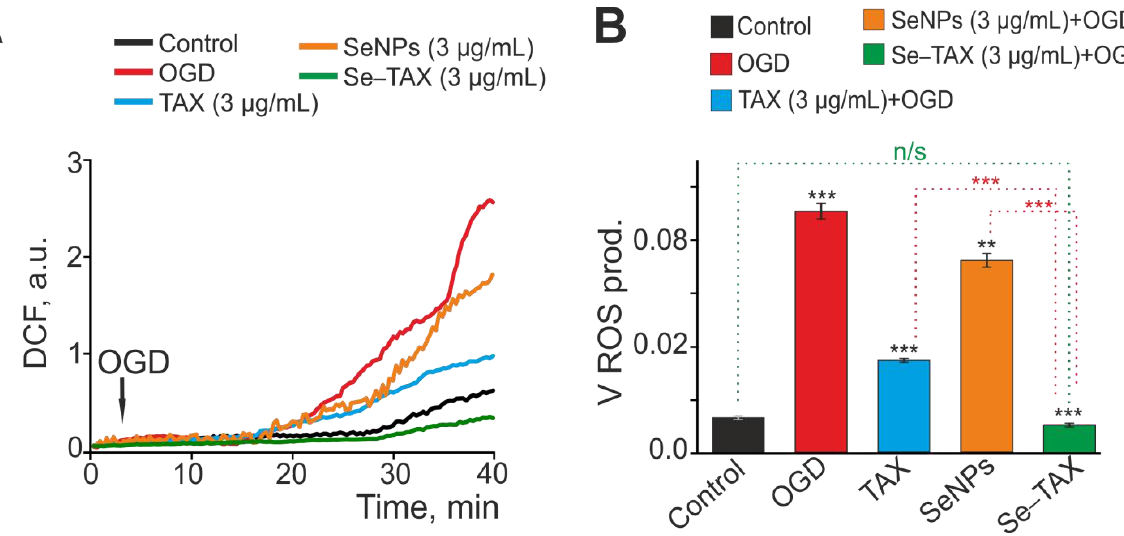
Figure 5. Effects of taxifolin (TAX), selenium nanoparticles (SeNPs), and selenium–taxifolin nanocom- plex (Se–TAX) on OGD-induced ROS production. ( A ) Total ROS production during OGD (40 min) depending on a 24 h incubation of the cell cultures with 3 µ g/mL TAX, 3 µ g/mL SeNPs, or 3 µ g/mL Se–TAX. Average curves plotted according to data from several dozen cells are represented. ( B ) Effect of the TAX, SeNPs, or Se–TAX on the ROS production rate. The average ROS production rates within the interval from the point of OGD onset to the end point of the experiment are